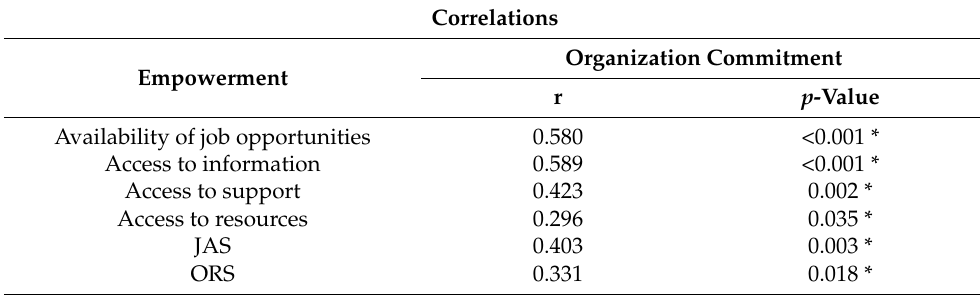
Table 7. The correlation between Organization Commitment and Empowerment domains (Avail- ability of job opportunities, Access to information, Access to support, Access to resources, JAS, ORS).